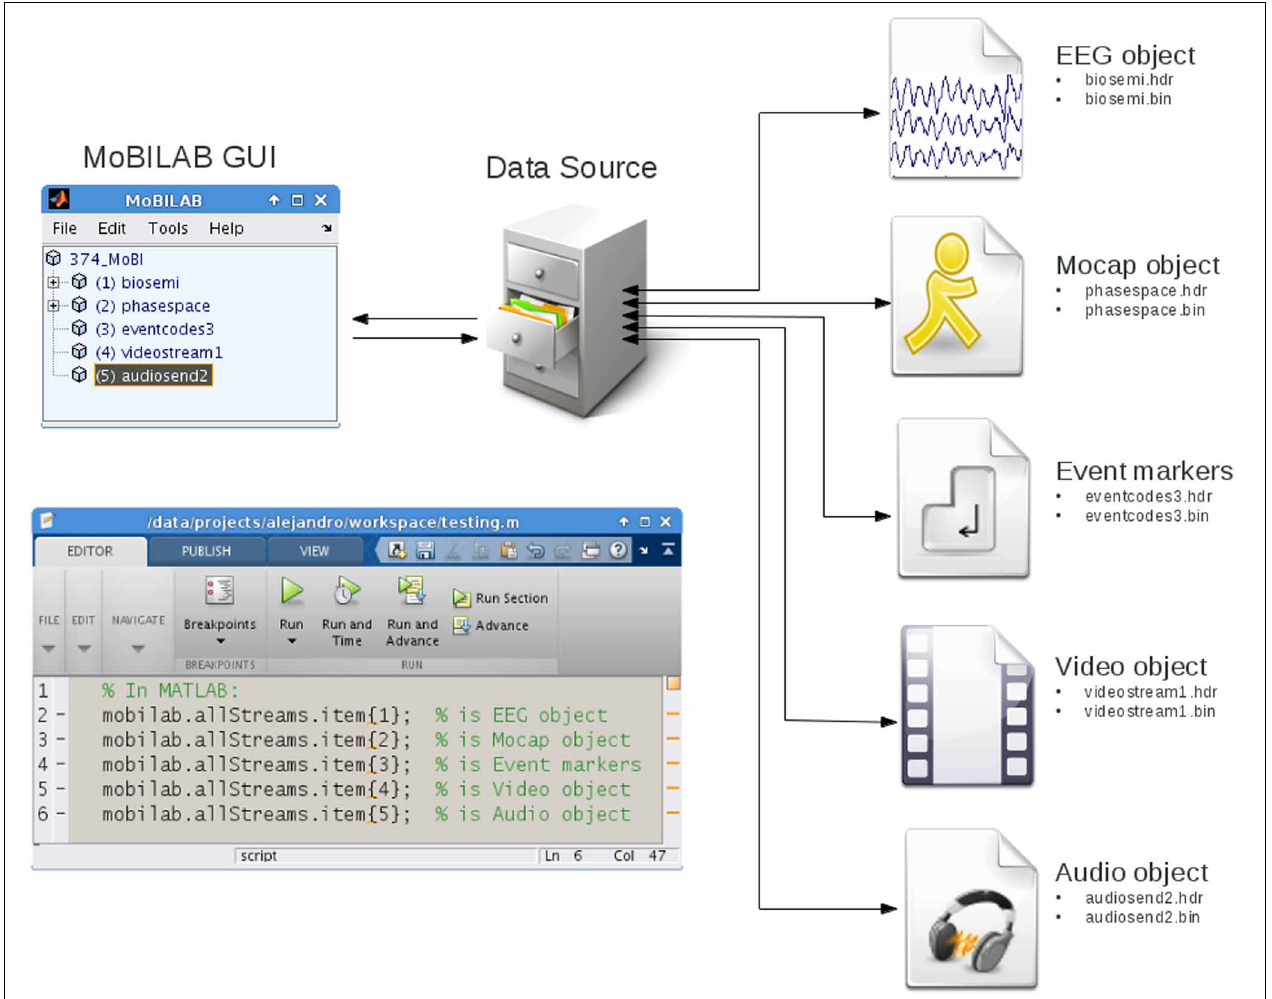
FIGURE 1 | The MoBILAB toolbox architecture. From left to right: through the MoBILAB GUI (upper left), the user can read new or previously processed data sets (right) in one of several formats [currently Lab Streaming Layer (.xdf), EEGLAB (.set), or MoBILAB (.hdr,.bin)] andinstantiatesacorresponding dataSource object that identifies the constituent data streams and creates stream-specific objects to handle them. Each data stream object defines